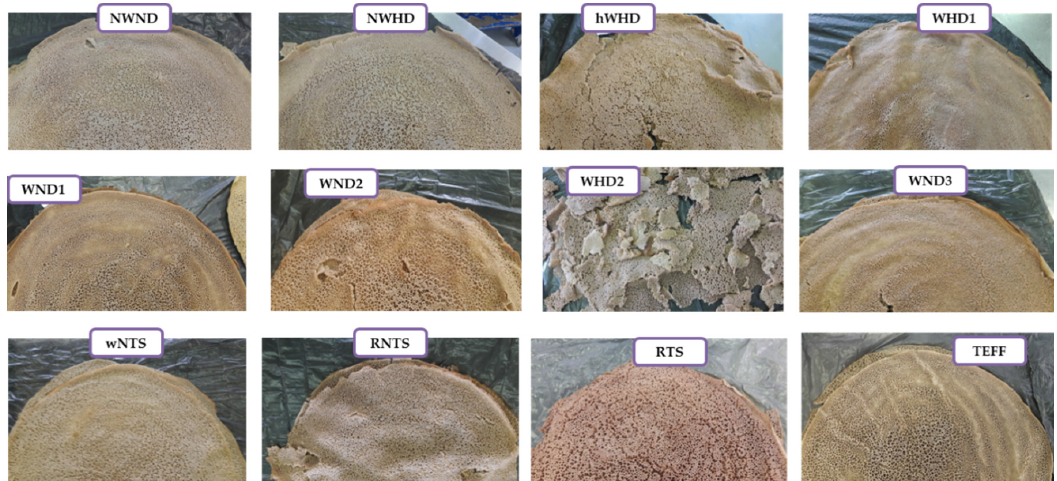
Figure 2. Visual appearance of the fresh sorghum and teff injera. NWND, non-waxy-normal protein